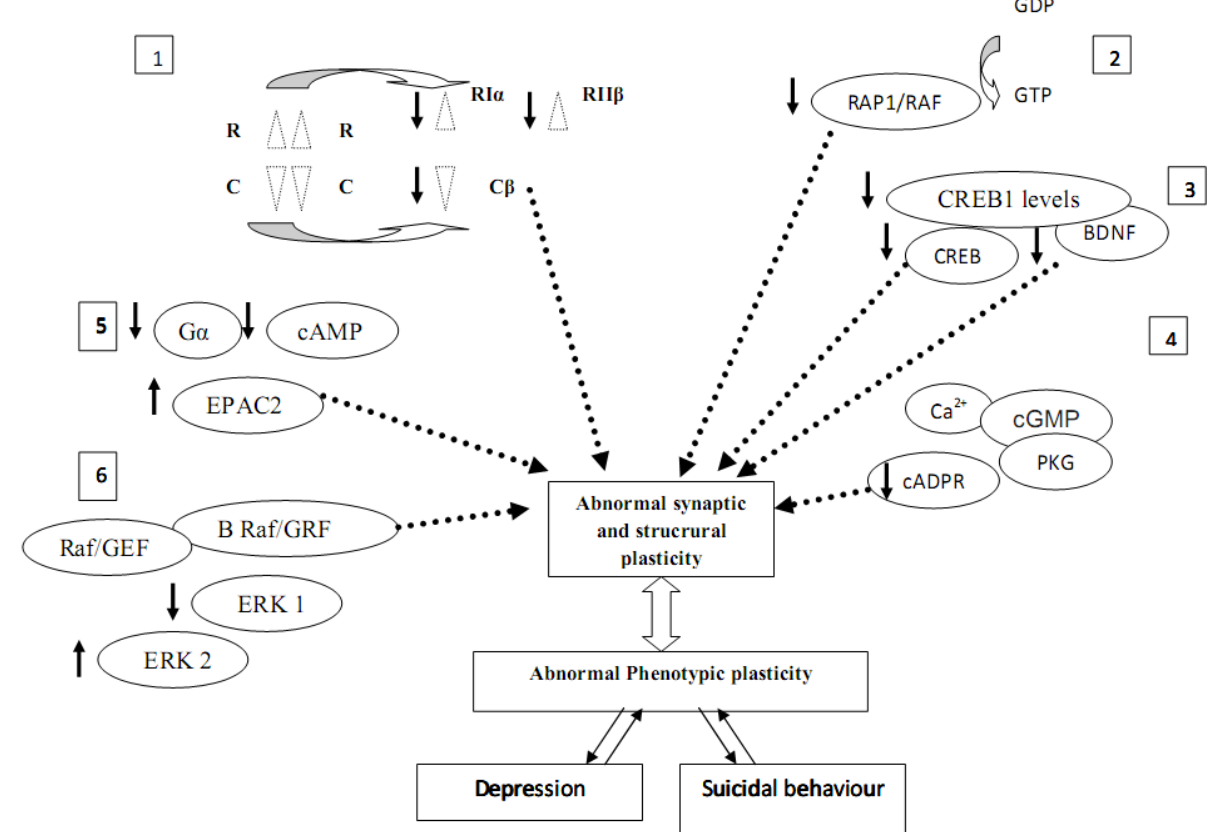
Overview of PKA, Rap1/RAF, CREB/BDNF, cADPR, c-AMP/EPAC2, ERK 1, ERK 2 alterations which may be involved in turn in depression and suicidal behaviour. Adapted from